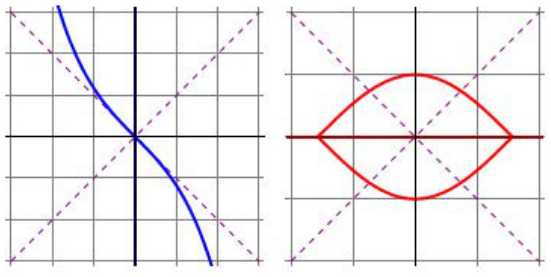
Fig. 11. Curves with K( y ) = − 1 / y ; spacelike (left), timelike (right).